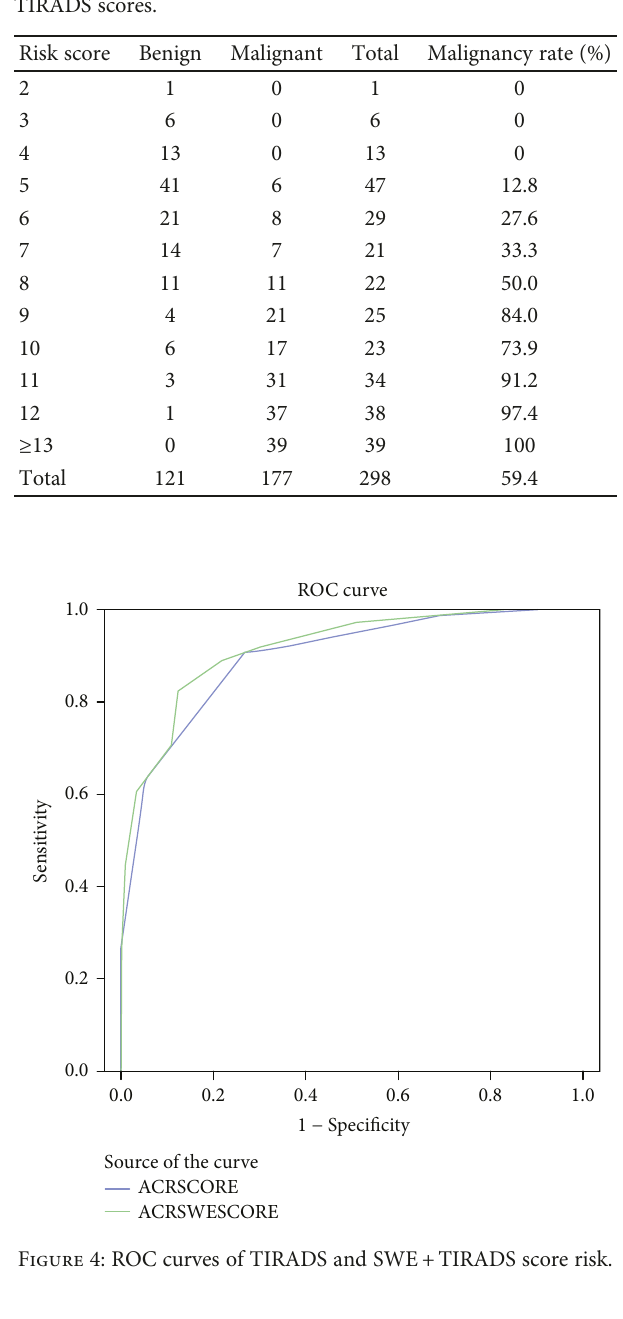
Table 6: Pathological distribution of 298 thyroid nodules based on E